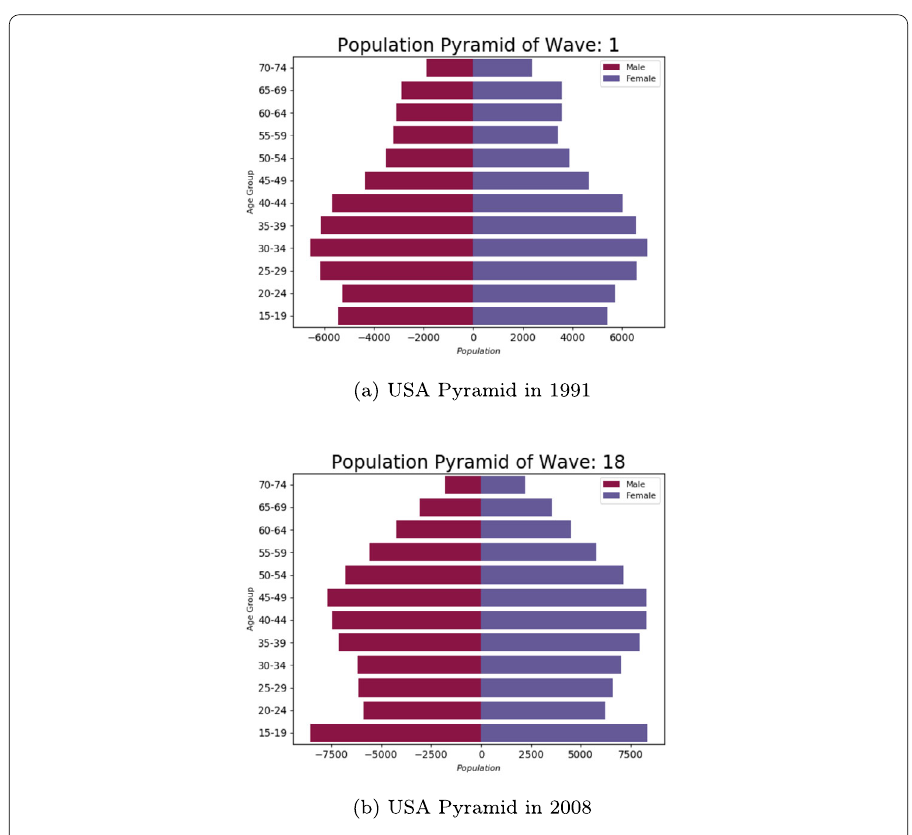
Figure 10 Population Pyramid for the USA Income between Ages 15–100 reflecting changes of age distribution in 18 years, which reflects mostly an aging